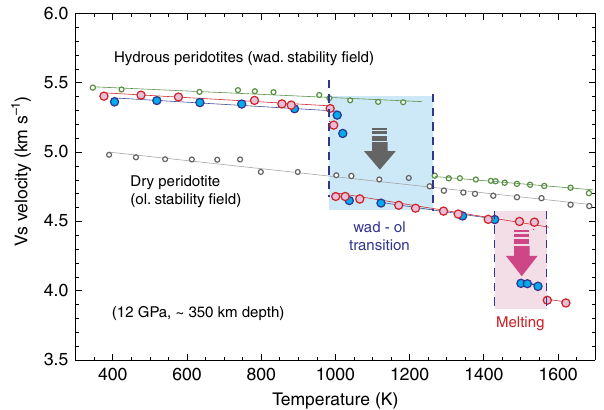
Fig. 1 Secondary wave velocity as a function of temperature for hydrous peridotites. Hydrous peridotites synthesized in the wadsleyite stability fi eld (14 GPa) and then re-equilibrated in the olivine stability fi eld (12 GPa) demonstrate two distinct velocity drops: the fi rst corresponding to the wadsleyite-to olivine transition at low temperature, and the second corresponding to the onset of melting at higher temperature. The hydrous peridotite with low-water content indicates velocity decrease corresponding to the wadsleyite-to-olivine phase transformation. The velocity variation of dry peridotite, synthesized at olivine stability fi eld, does not indicate any abrupt variation in sound wave velocity and follows the trend for general decrease of bulk and shear moduli with temperature. The blue, red, and green circles represent hydrous wadsleyite with 3600, 3000, and 600 wt. p.p.m. of H 2 O, synthesized at wadsleyite stability fi eld. The gray circles represent dry peridotite synthesized at olivine stability fi